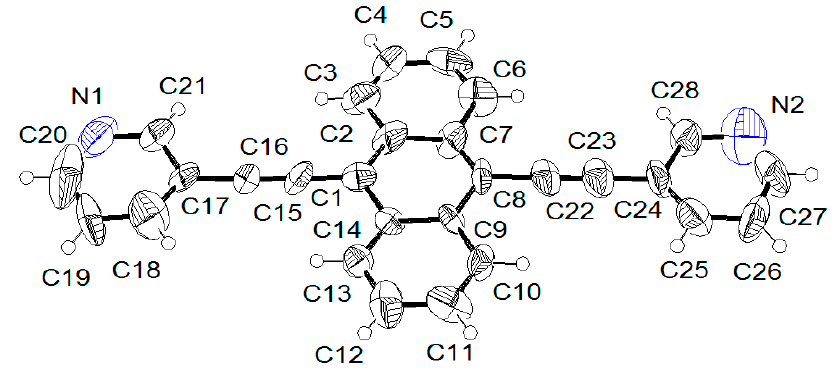
Figure 2. Ortep drawing of L anthr at 50% probability level ellipsoids.